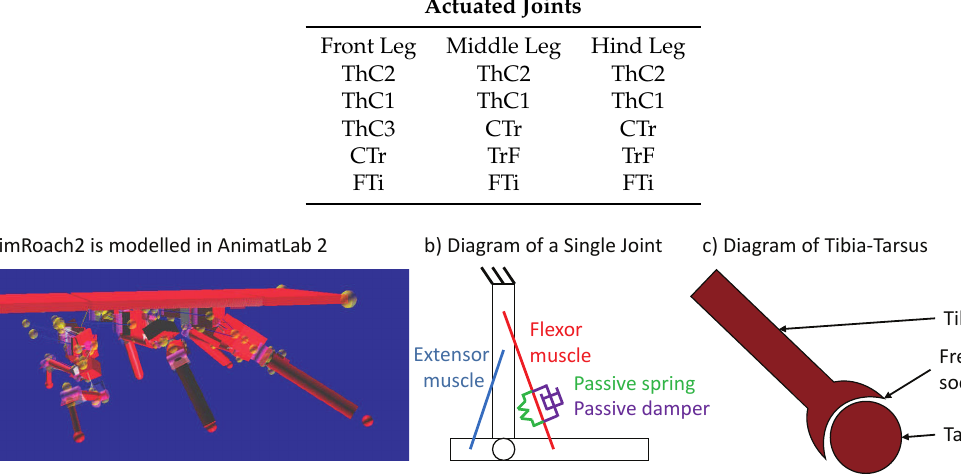
Figure 2. Physical model of the cockroach Blaberus discoidalis . ( a ) Picture of SimRoach2 in AnimatLab2; ( b ) each joint consists of a flexor muscle, extensor muscle and a passive spring and damper attached at the same points as the flexor muscle; ( c ) each tarsus (foot) is attached to the tibia with a free ball and socket joint that “sticks” when in contact with the